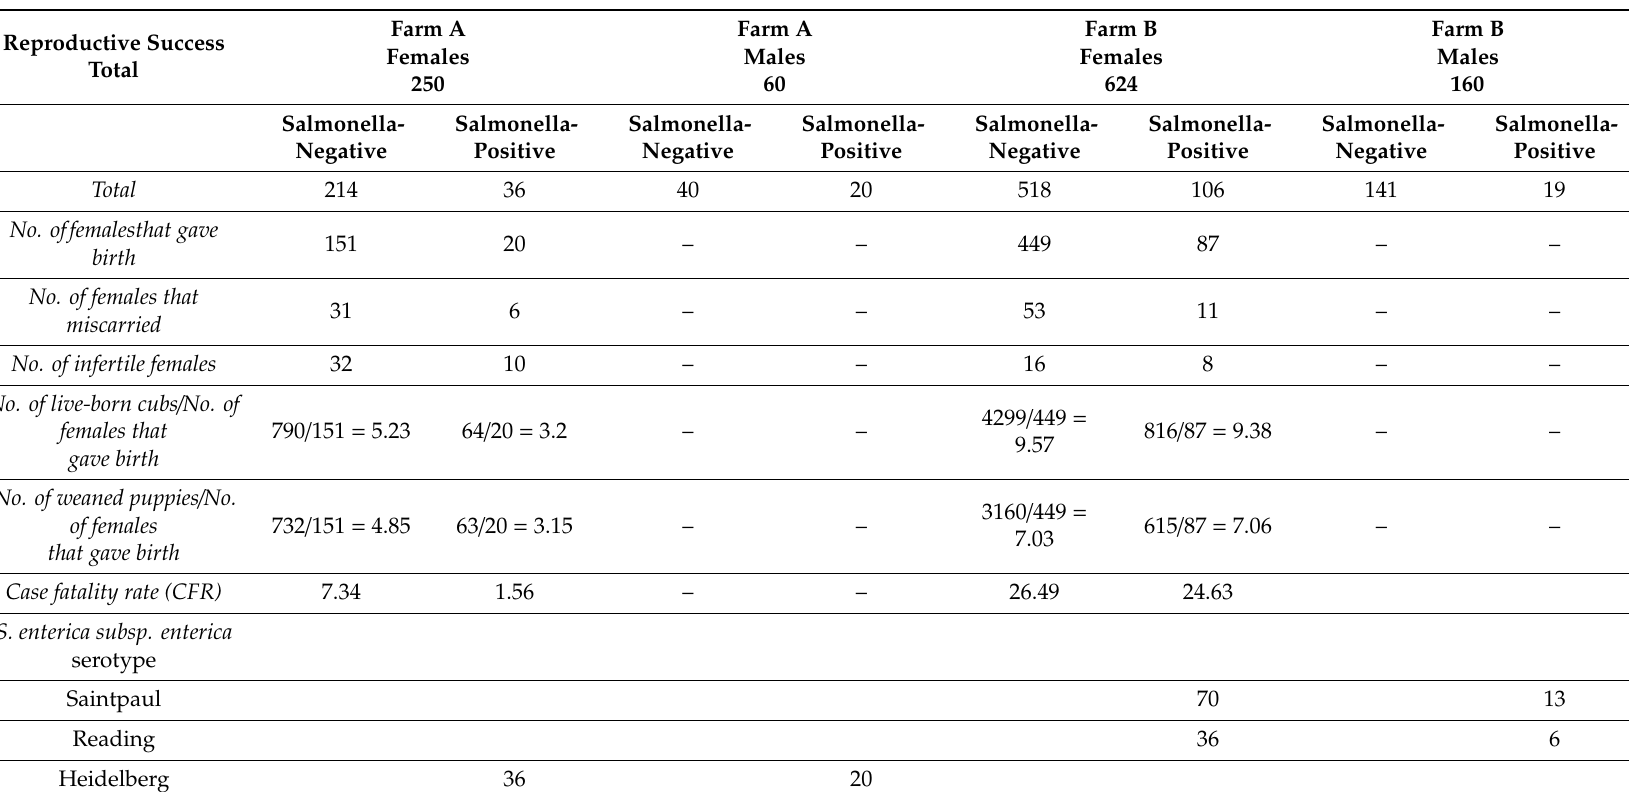
Table 1. Prevalence of Salmonella spp. and reproductive success in Arctic foxes ( Alopex lagopus